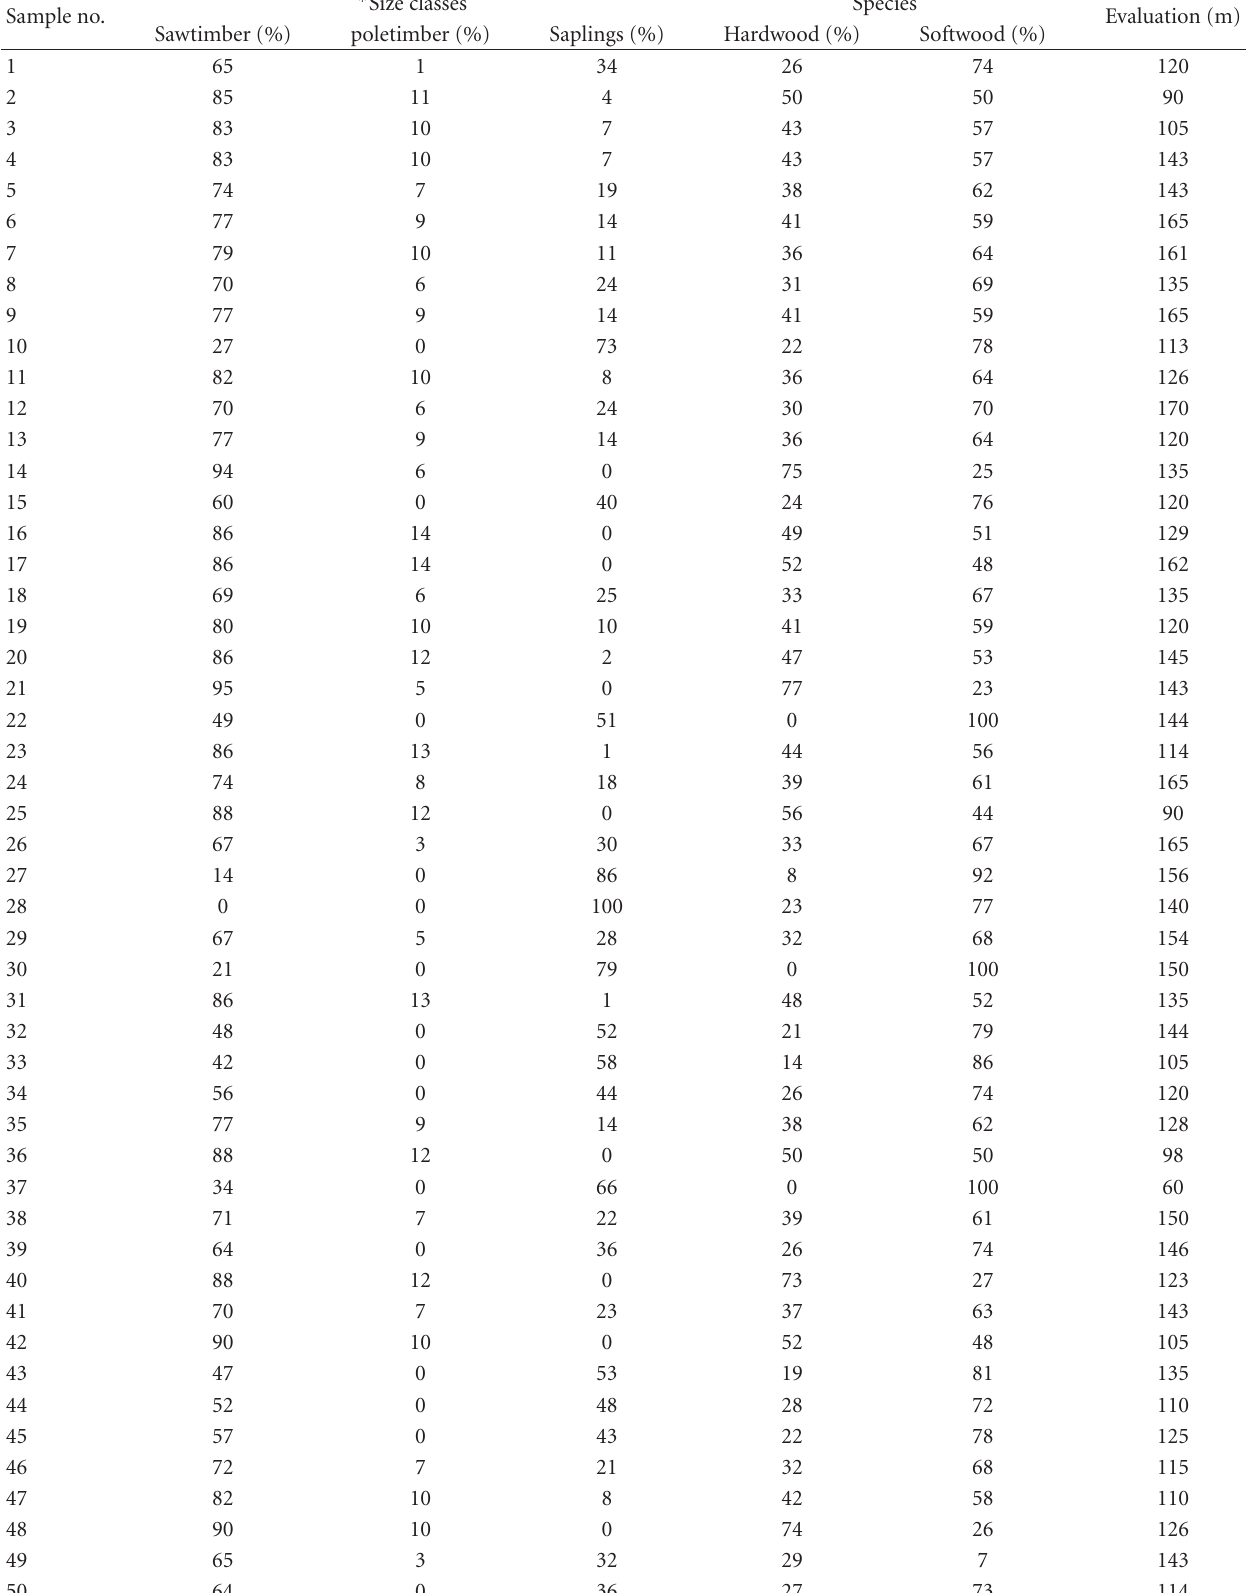
Table 2: In situ forest data of Oakmulgee National Forest, AL, USA. Sample